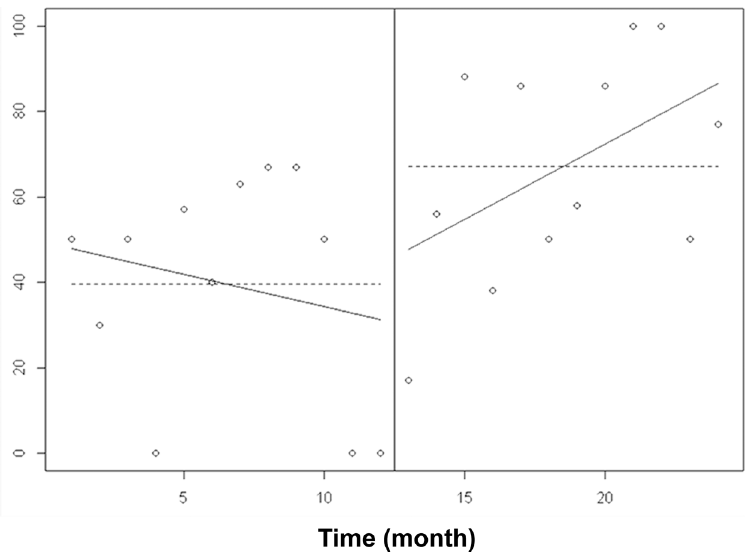
Figure 5. Proportion of patients with a prescribed calorie intake between 80 and 120% of recommended intake. The linear trend of adequately targeted calorie intake ordering over one year was significantly higher (p , 0.0001) after than before implementation of the computer help. This suggests that there was a continuous improvement in calorie ordering over time after the implementation of the computer help.